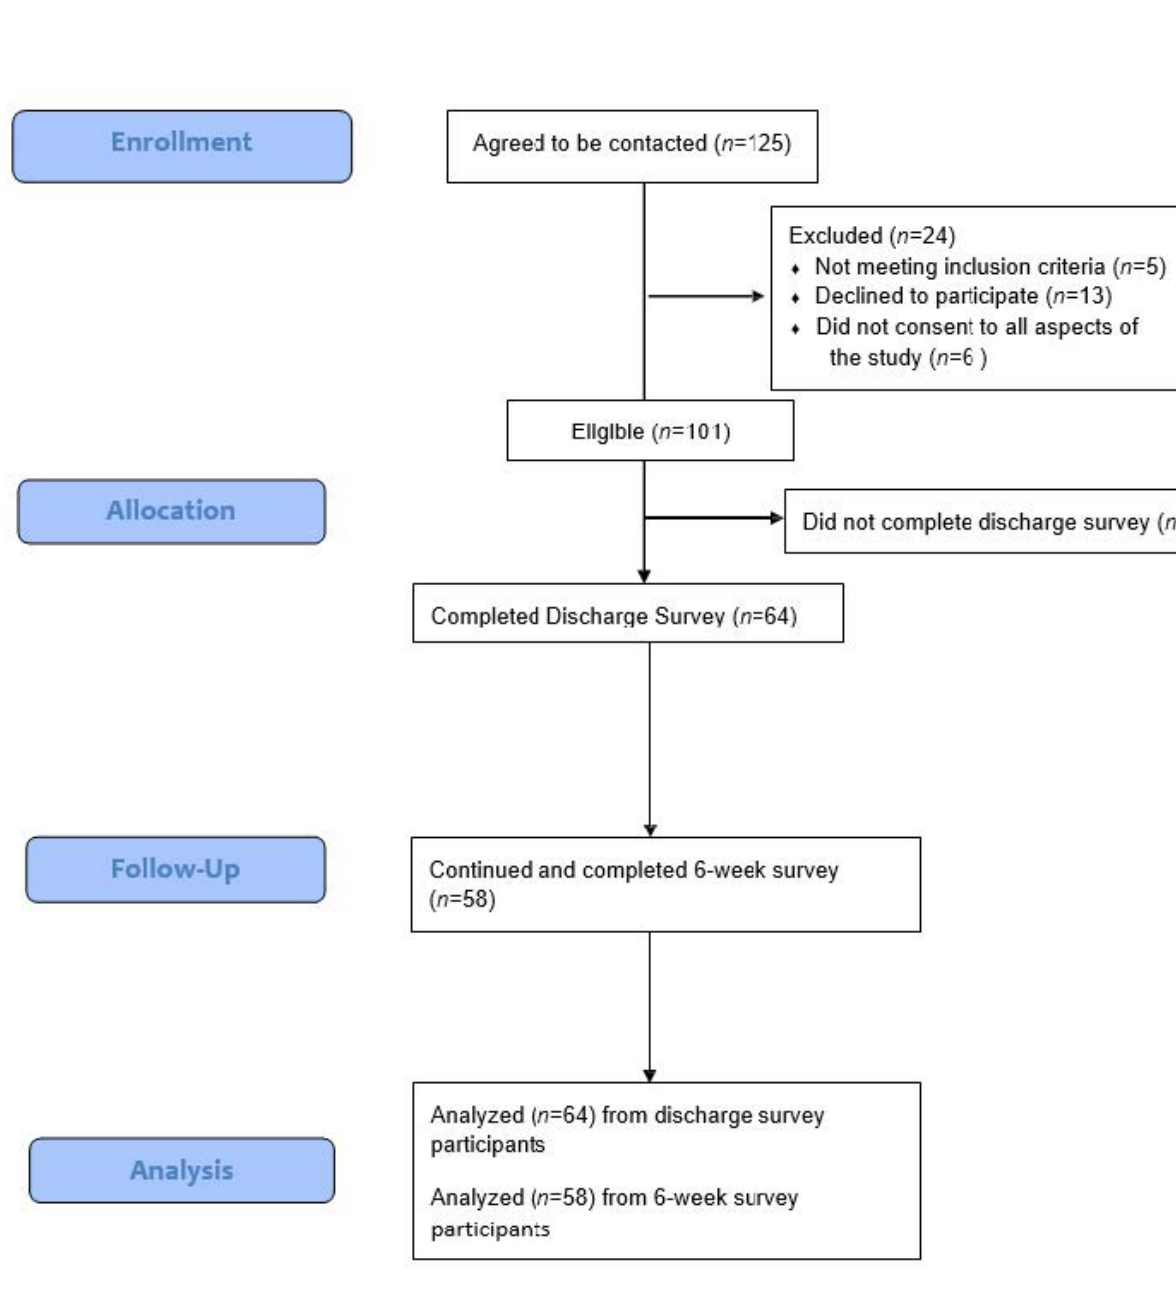
Figure 1. Participant enrollment. Maternal characteristics of parturients with GAD-7 scores at hospital discharge < 10 and ≥ 10 were similar except for insurance provider; more patients with anxiety had